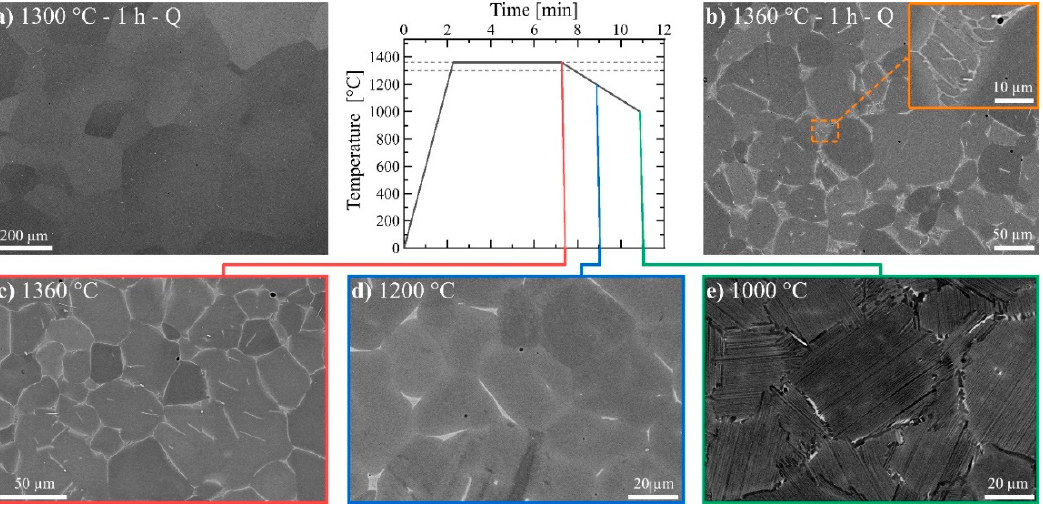
Figure 4. Microstructures of the TNM + alloy after various heat treatments: ( a , b ) correspond to 1 h heat treatments followed by quenching; ( c – e ) quenching from specific temperatures during the reproduced SPS cycle. The temperatures given in ( c ) through ( e ) mark the respective temperatures before the quenching to room temperature, e.g., see the time-temperature curve in the centre.